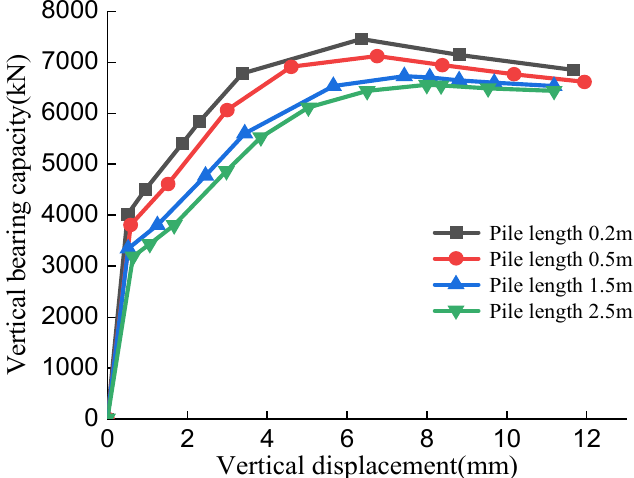
Figure 20. Comparison of different pile lengths.